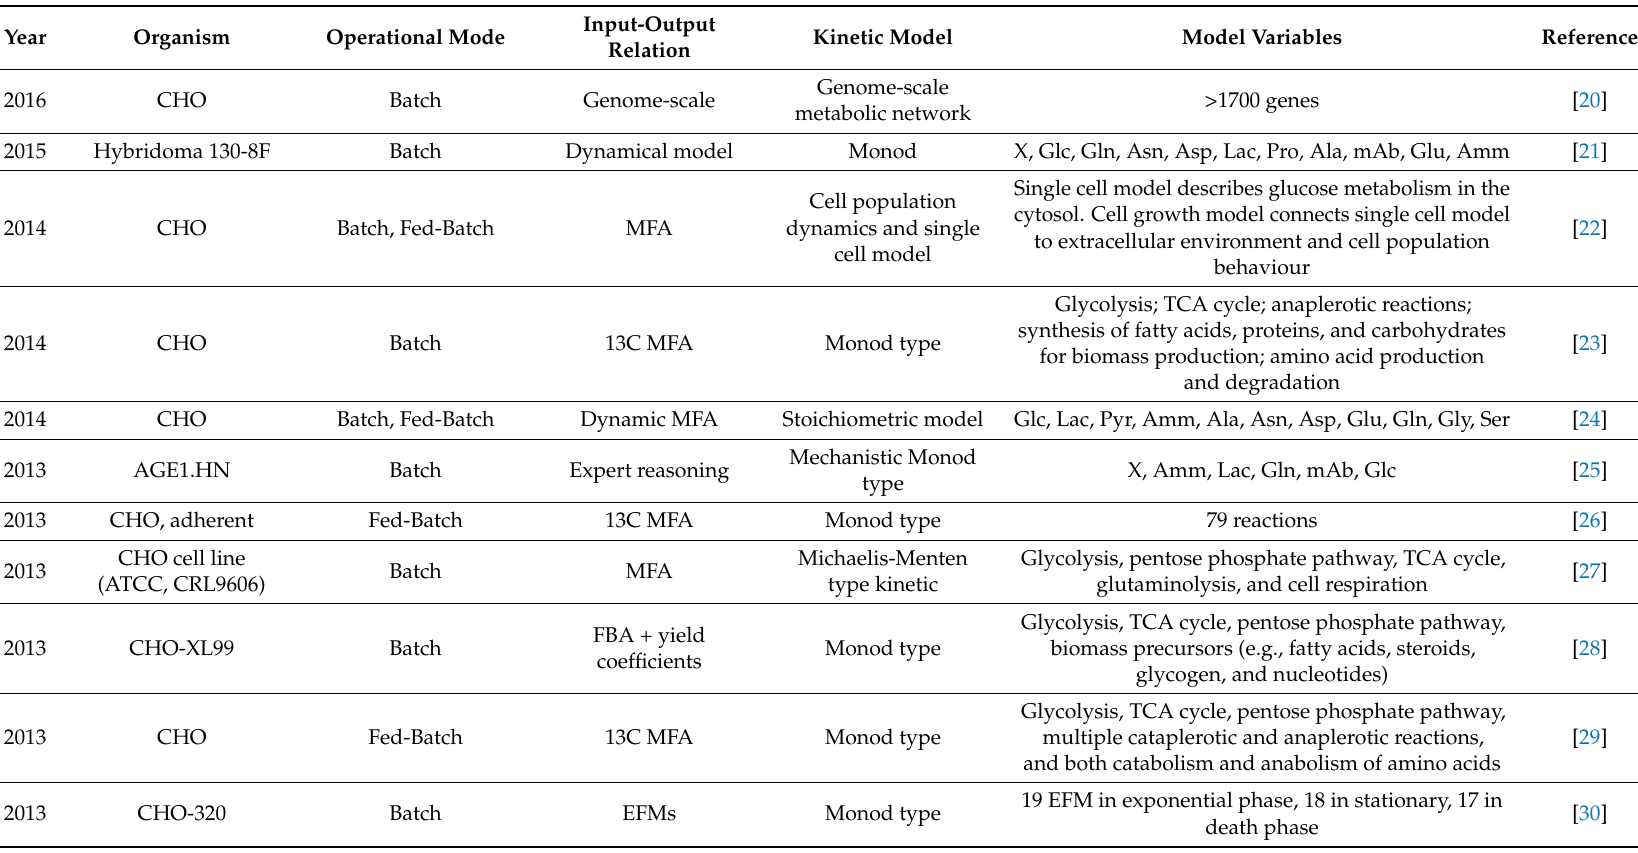
Table 1. General overview of working groups focusing on upstream process modelling. CHO, Chinese hamster ovary; MFA, metabolic flux analysis; TCA, tricarboxylic acid cycle; EFM, elementary flux mode; PFA, principal factor analysis; FBA, flux balance analysis; ANN, artificial neural